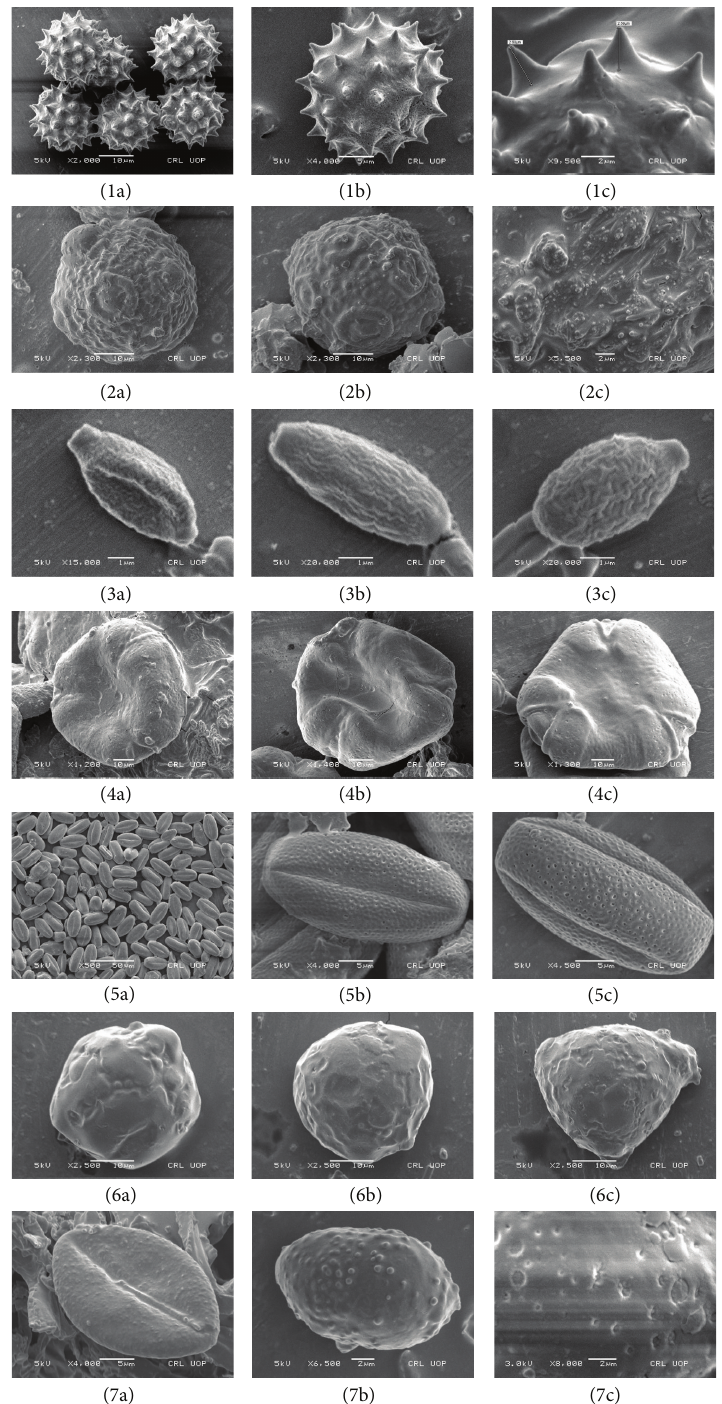
Figure 3: Palynological studies of pollen grains of seven high valued medicinal plants. (1a)–(1c) Pollen morphology of Achillea millefolium (2a)–(2c) Fumaria indica (3a)–(3c) Origanum vulgare (4a)–(4c) Paeonia emodi (5a)–(5c) Peganum harmala (6a)–(6c) Psoralea corylifolia (7a)–(7c) Rauwolfia serpentine